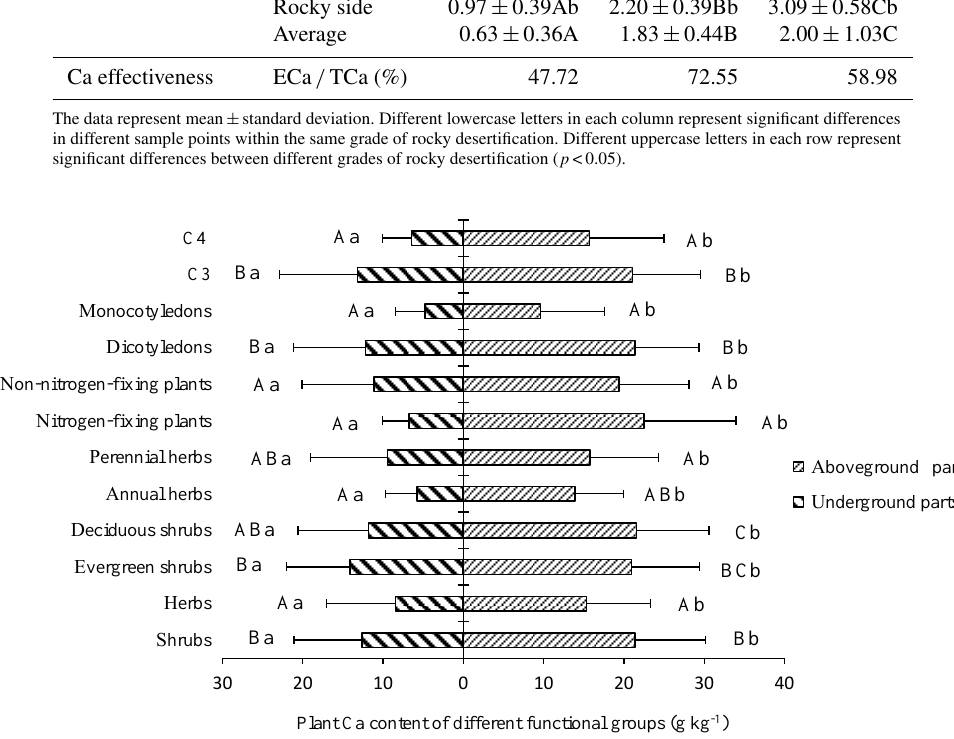
Figure 3. Ca content in the aboveground and belowground parts of plants in different functional groups. Different lowercase letters represent significant differences between the Ca content of the aboveground and belowground parts for the same functional groups ( p <0.05); different uppercase letters represent significant differences among different functional groups ( p